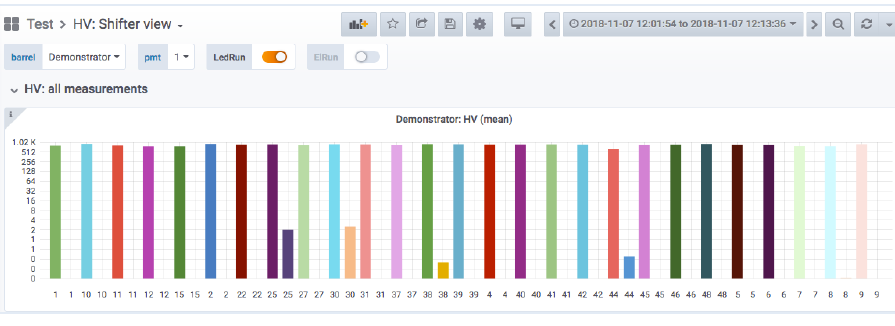
Fig. 6. HV and HV delta values grouped by